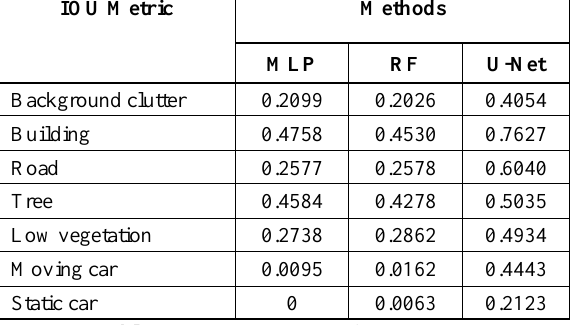
Table 1 . IOU metric results for each class.